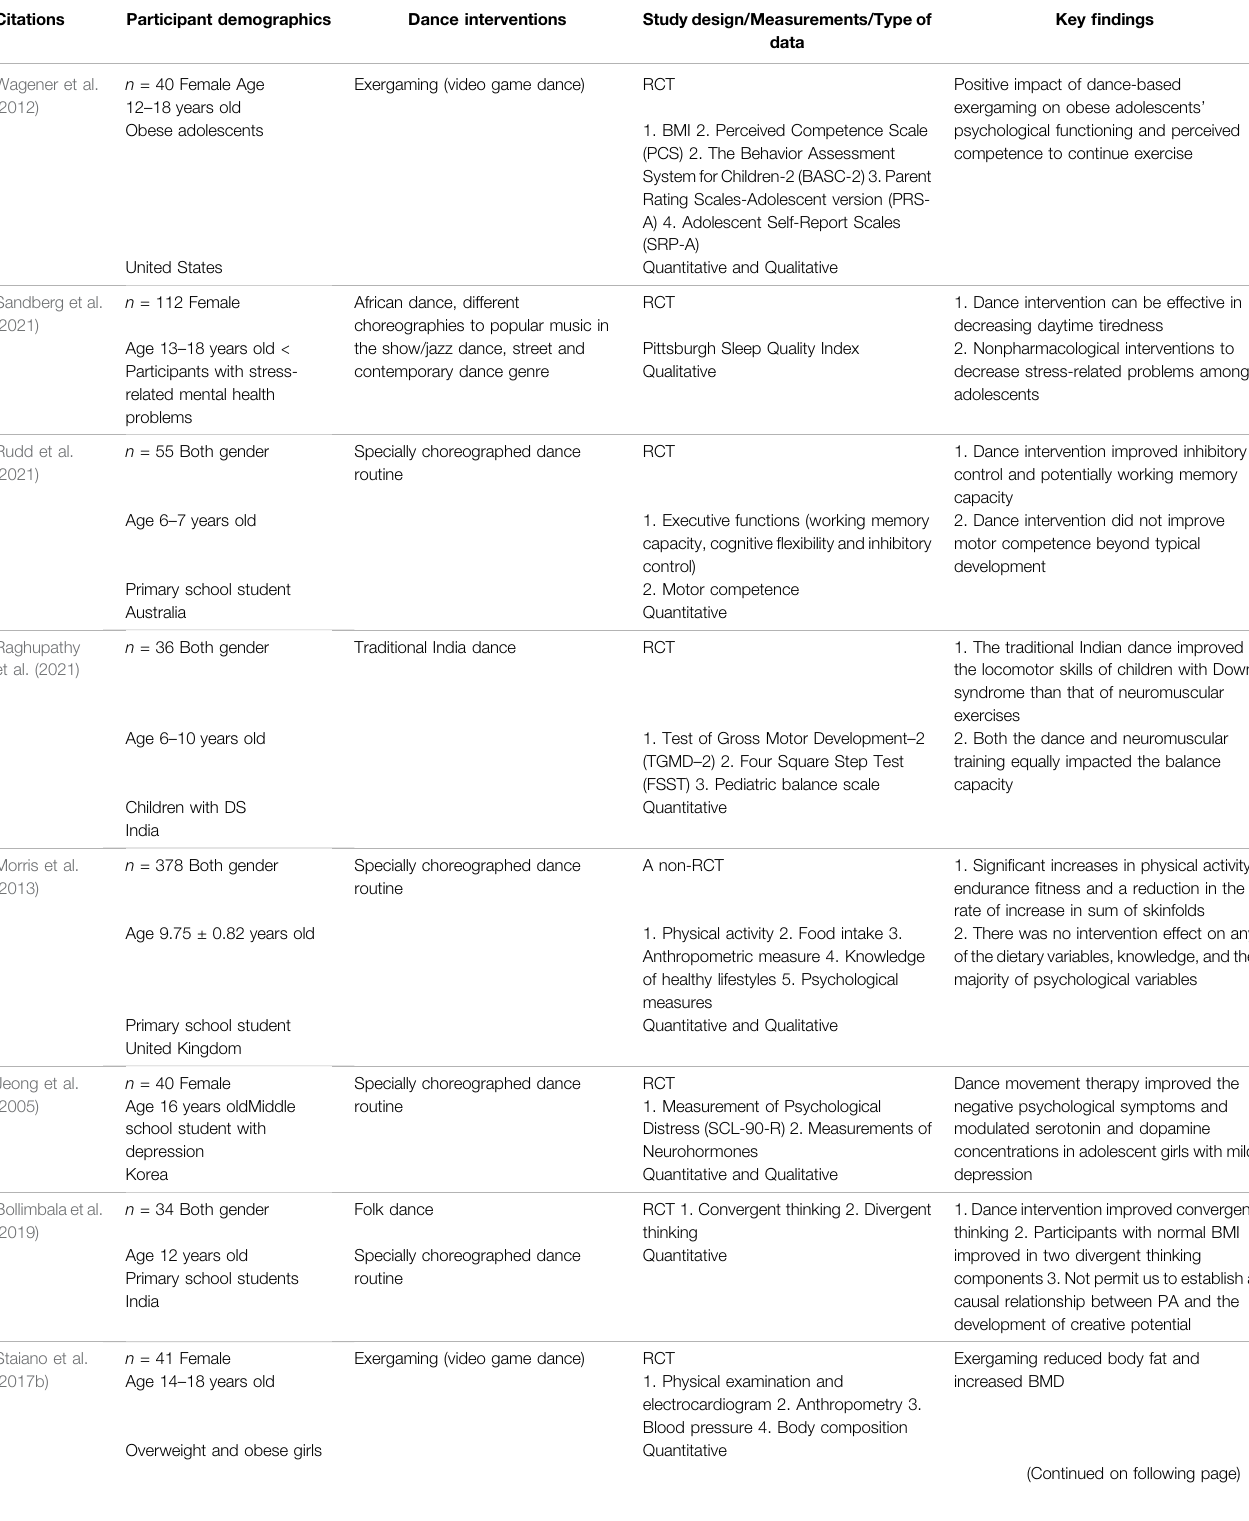
TABLE 2 | Detailed summary of the study